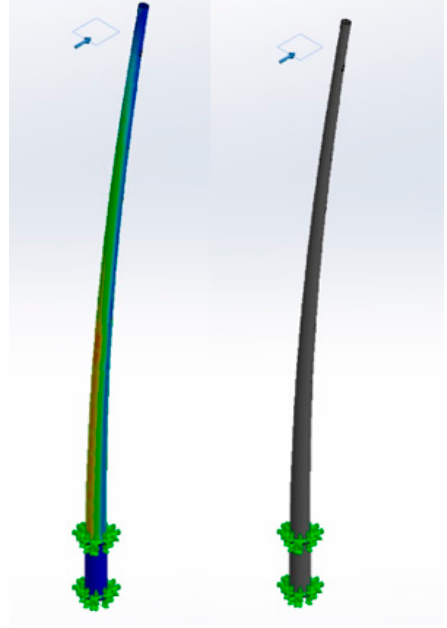
Figure 13. FE mesh of the